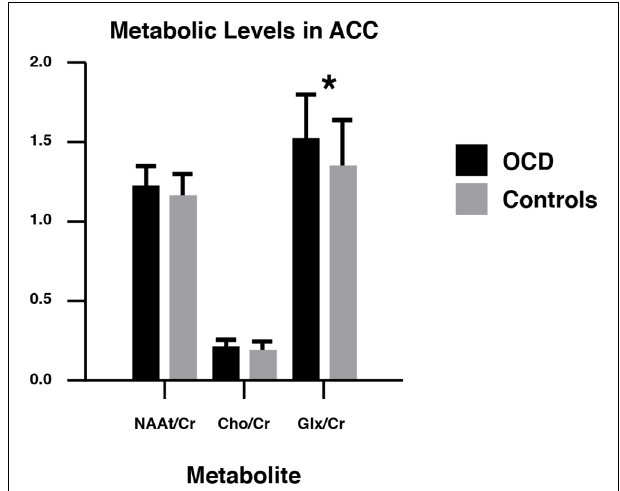
FIGURE 2 | NAAt/Cr, Cho/Cr, and Glx/Cr concentrations in obsessive-compulsive disorder (OCD) patients and healthy controls in the ACC. NAAt, Total N -acetyl-aspartate; Cho, choline; Glx, glutamate–glutamine; Cr, creatine + phosphocreatine. ACC, anterior cingulate cortex. ∗ p < 0.05.